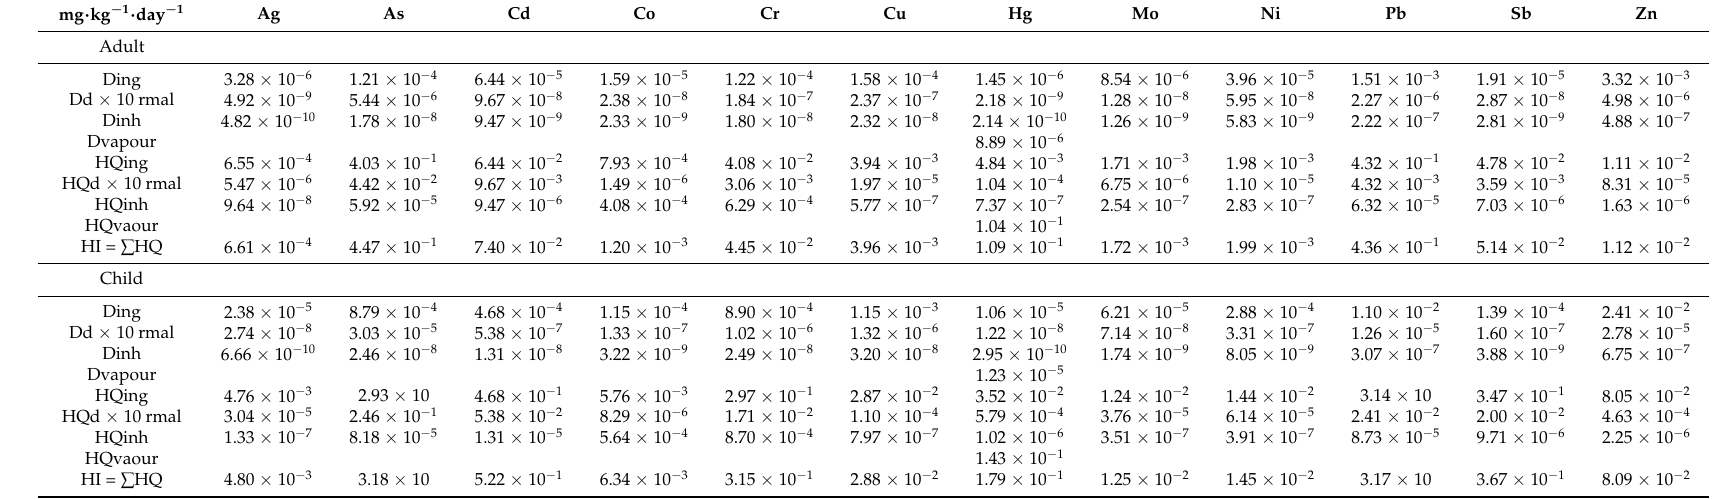
Table 4. Daily exposure amounts and hazard quotient of metals in street dust to adult and child through three